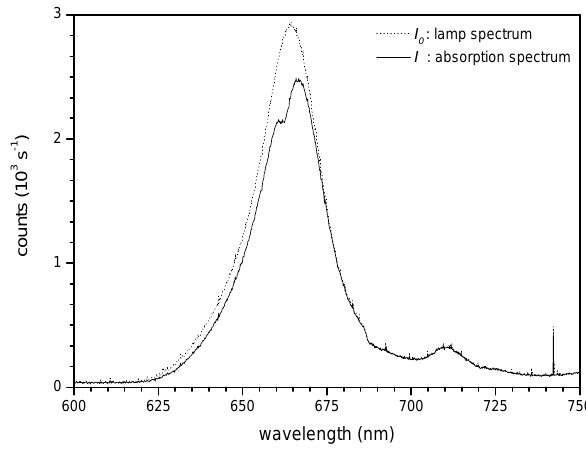
Figure 4. Detection of NO 3 in a large background of O 3 in air. The solid line shows the absorption coefficient of the samples calculated by conventional CEAS means from a data set as shown in Fig. 3. The offset is due to absorption of ~5 ppm Ozone in the cavity (dotted, red). The NO 3 peak is due to a concentration of ~360 ppt (dotted, blue). Residual (mainly from NO 2, grey). This rough estimation of concentration based on Eq. 3 and Eq. 10 coincides with the DOAS analysis results. There was no polynomial used in the fit to avoid co-variation possible with the ozone signal.